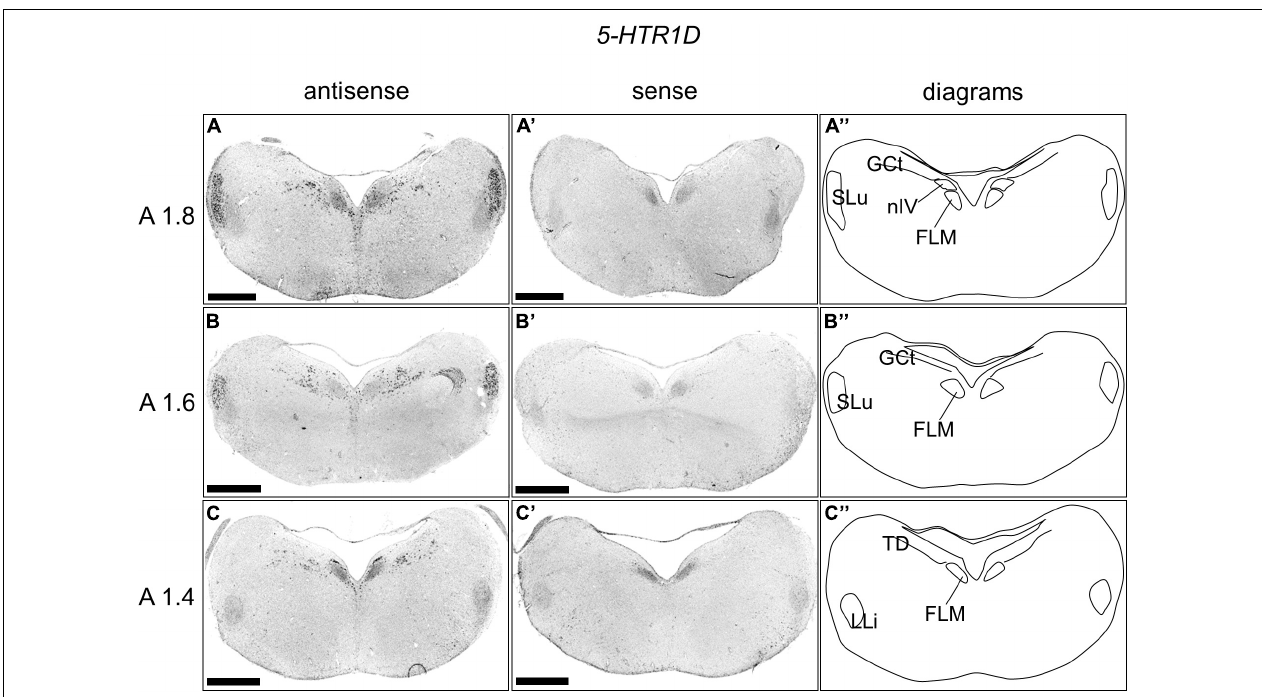
FIGURE 5 | In situ hybridization of 5-HTR1D in the P1 chick brainstems. Digoxigenin-labeled RNA antisense (A–C) and sense (A’–C’) 5-HTR1D probes were used for in situ hybridization in coronal sections of P1 chick brains. To evaluate the expression patterns of 5-HTR1D , sections of five chicks were analyzed, and representative images of two chick brain sections are shown. (A”–C”) Diagrams of coronal sections are shown in the rightmost panels. The levels of the sections (A1.8, A1.6, and A1.4) are in accordance with those mentioned in Kuenzel and Masson’s chick atlas (Kuenzel and Masson, 1988). FLM, fasciculus longitudinalis medialis; GCt, griseum centrale; LLi, nucleus ventralis lemnisci lateralis; nIV, nucleus nervi trochlearis; SLu, nucleus semilunaris; TD, nucleus tegmenti dorsalis; P1, post-hatch day 1. Scale bars = 1